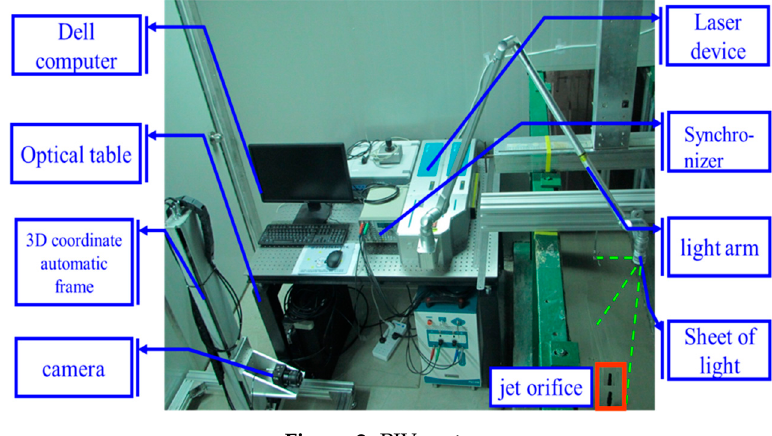
Figure 2. PIV system.